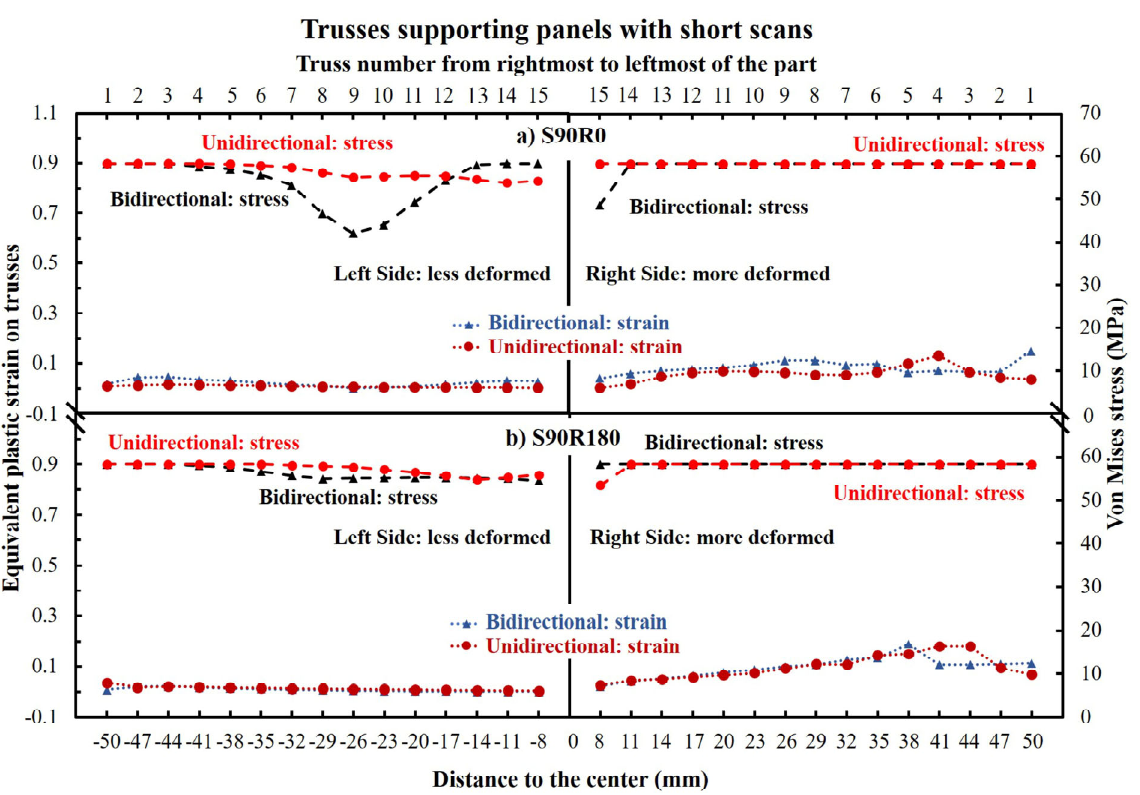
Figure 17. The equivalent plastic strain and von Mises stresses on each truss of the parts made with short ‐ Y scans.